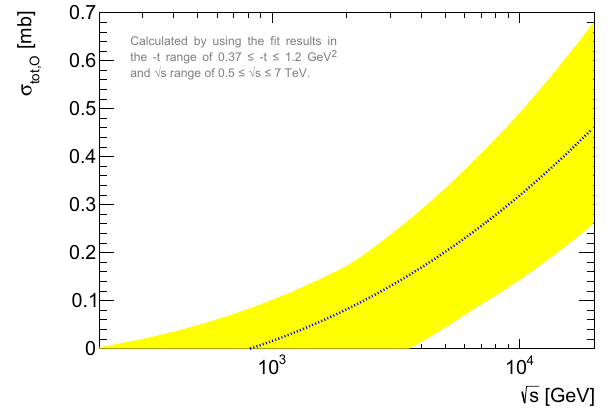
Fig. 28 Excitationfunctionofthetotalcross-sectionobtainedfromthe opticaltheoremusingtheReBBmodelamplitudeofOdderonexchange, as evaluated from the log-linear excitation functions of the opacity parameters α pp ( s ) and α p ¯ p ( s ) as well as that of the scale parame- ters, R q ( s ) , R d ( s ) , R qd ( s ) , corresponding to Table 2. The yellow band indicates our conservative estimate on the systematic errors of the total cross-section of this Odderon exchange. The result indicates that total cross-section of the Odderon exchange is sharply increasing in the few TeV energy range, but it is two orders of magnitude smaller than the contribution of the Pomeron exchange that is dominant at the same energy scale